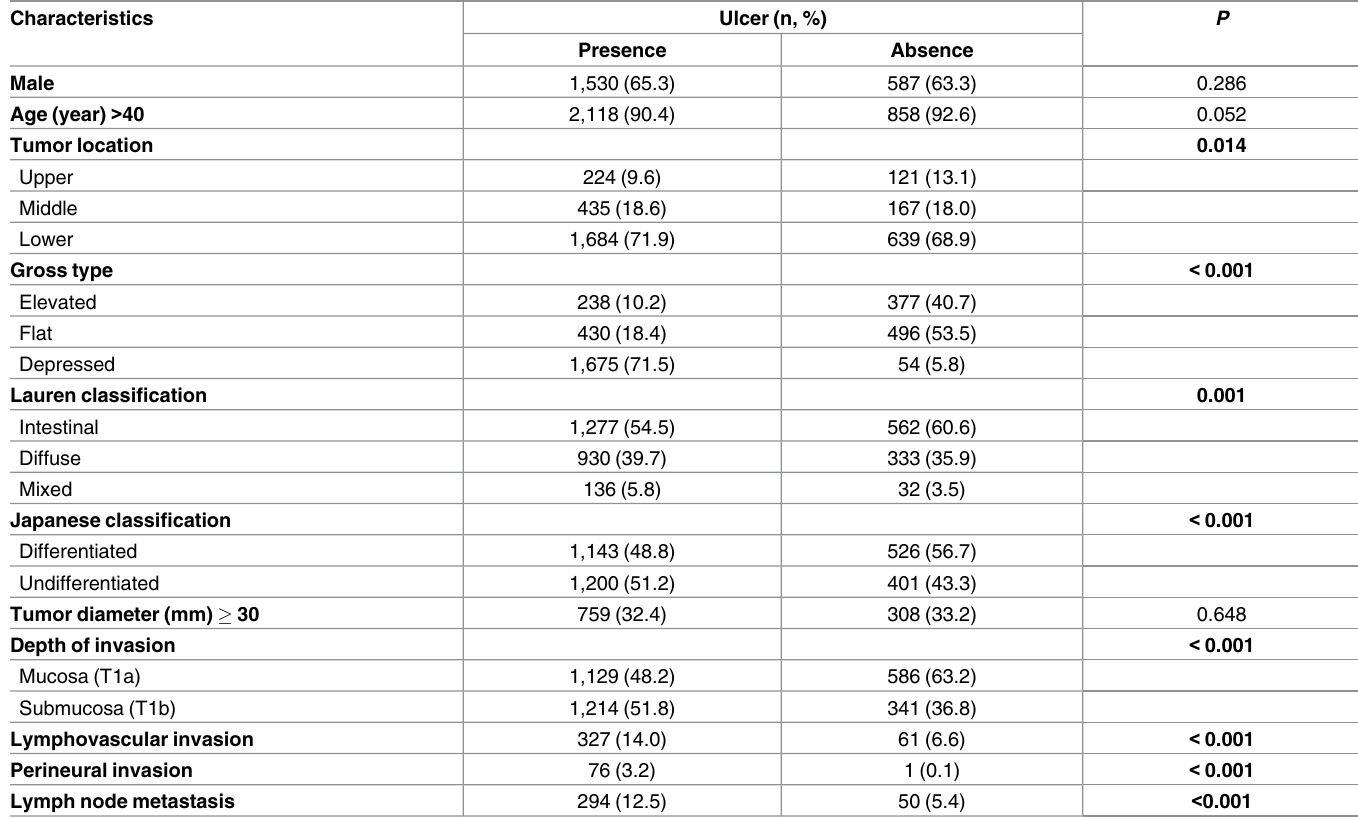
Table 2. Clinicopathologic Characteristics in Relation to the Presence of Endoscopic Ulcer in Early Gastric